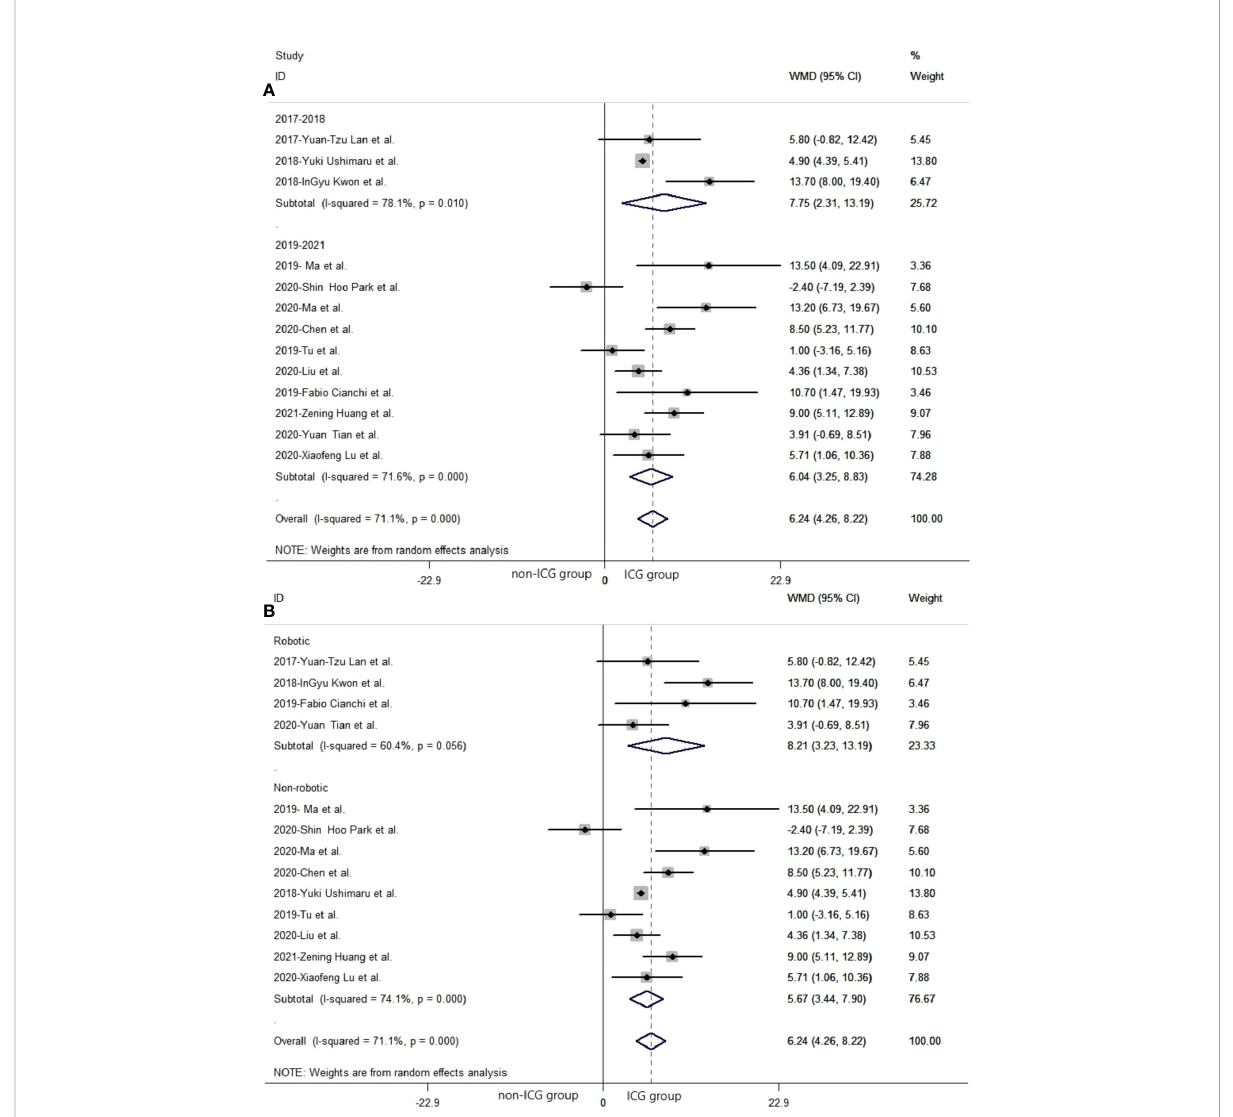
FIGURE 3 The pooled weighted mean difference of ef fi cacy of included studies related to subgroup analysis. (A) The pooled weighted mean difference of ef fi cacy of included studies related to different year of publication. (B) The pooled weighted mean difference of ef fi cacy of included studies related to different types of laparoscopic